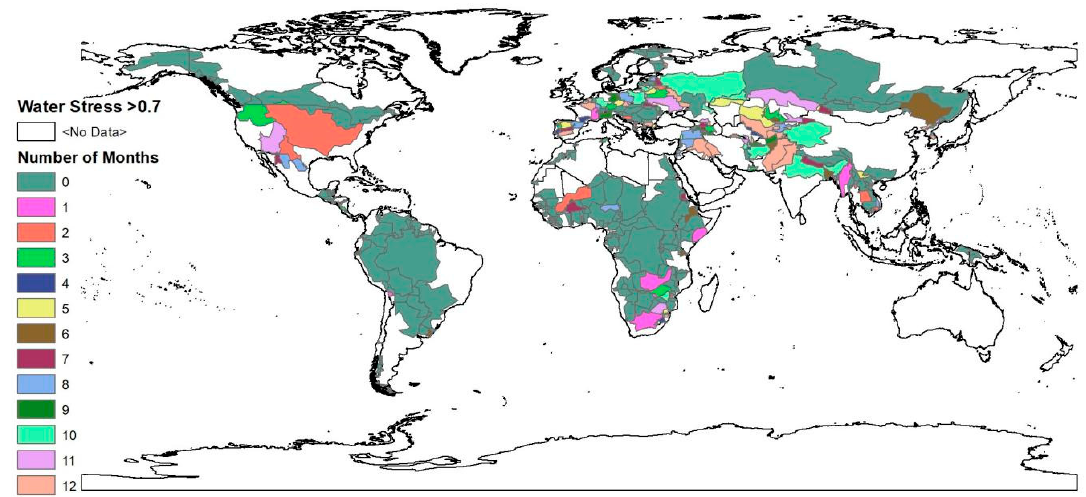
Figure 2. The number of months each sub-basin spends under different levels of water stress. This map was generated with ArcGIS 10.2 for desktop from Environmental Systems Research Institute (ESRI) [25].